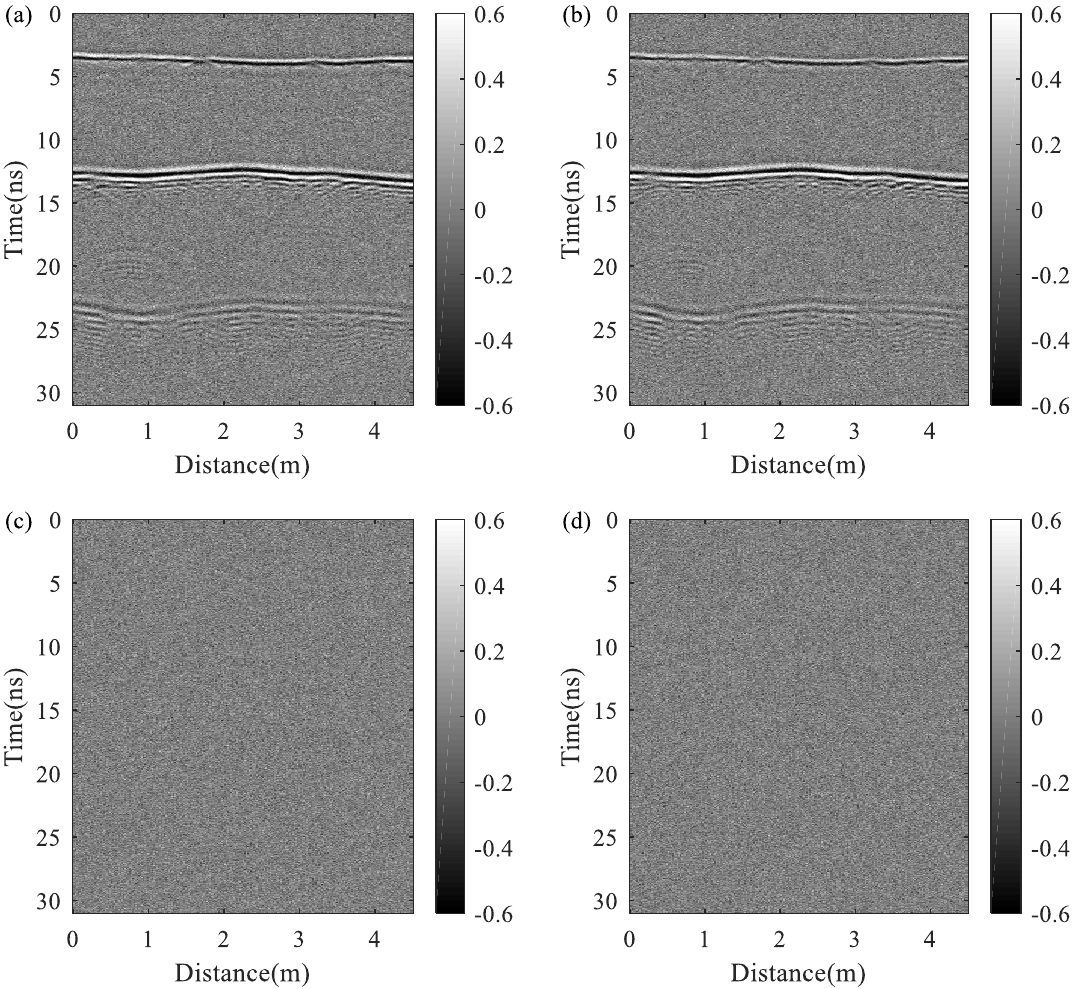
Figure 2. Profiles of noise added FP-SPR data. ( a ) VV mode. ( b ) HH mode. ( c ) VH mode. ( d ) HV mode.